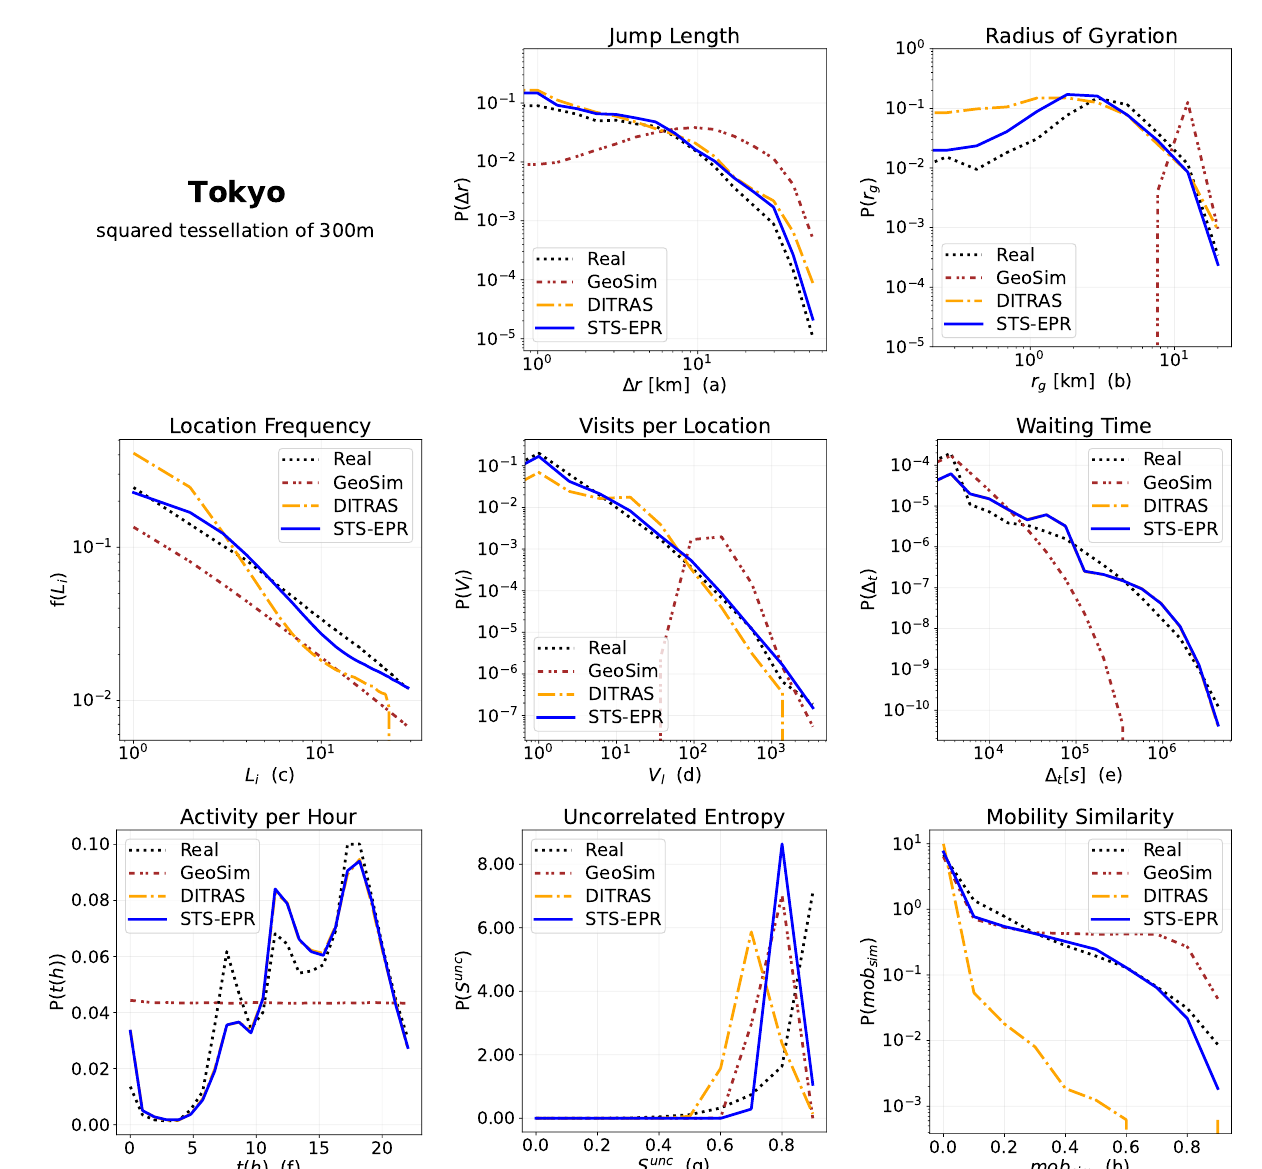
Figure 5. Comparison of the distribution of the mobility measures jump length ( a ), radius of gyration ( b ), location frequency ( c ), visits per location ( d ), waiting time ( e ), activity per hour ( f ), uncorrelated entropy ( g ), and mobility similarity ( h ) of real data (black dotted line) and data produced by GeoSim (red dash-dotted line), DITRAS (orange dash-dotted line), and STS-EPR (blue line), for Tokyo and the squared tessellation with tiles of